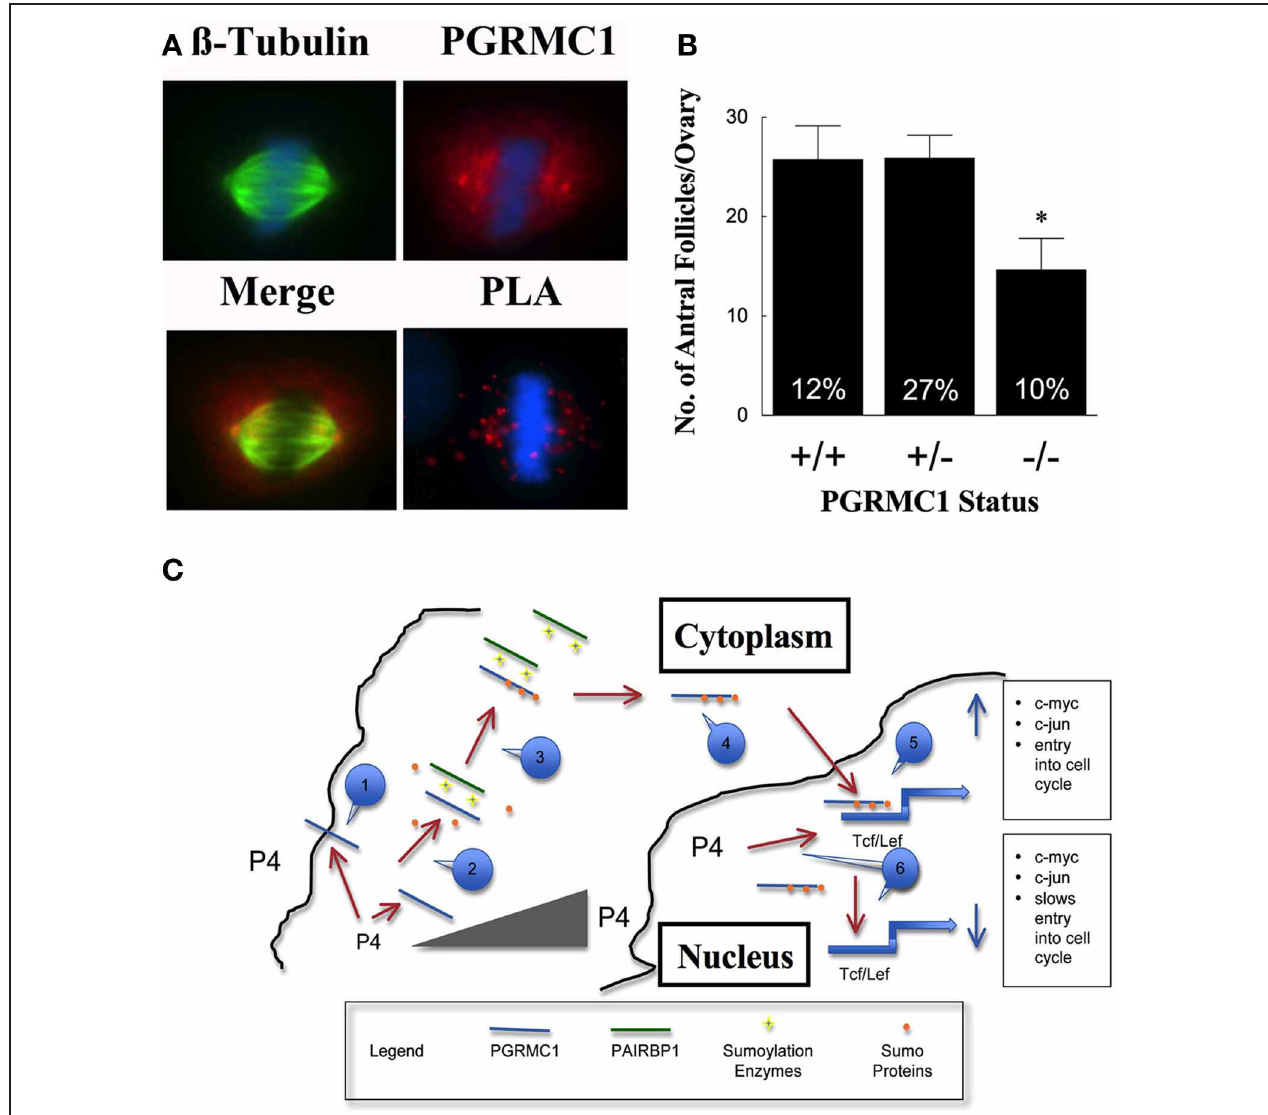
FIGURE 2 | In (A) the co-localization of β -tubulin (green) and PGRMC1 (red) in relationship to metaphase chromosomes (blue) is shown in SKOV3 cell. Also shown is interaction between PGRMC1 and β -tubulin as revealed by in situ Proximity Ligation Assay (PLA). The presence of red fluorescent dots in the PLA assay indicates that two proteins are in close proximity (i.e., interacting). DNA is counterstained with DAPI (blue). Negative controls were conducted and did not show any staining. (Images are from Figures 5 to 7 from Lodde and Peluso, 2011). (B) Shows the number of